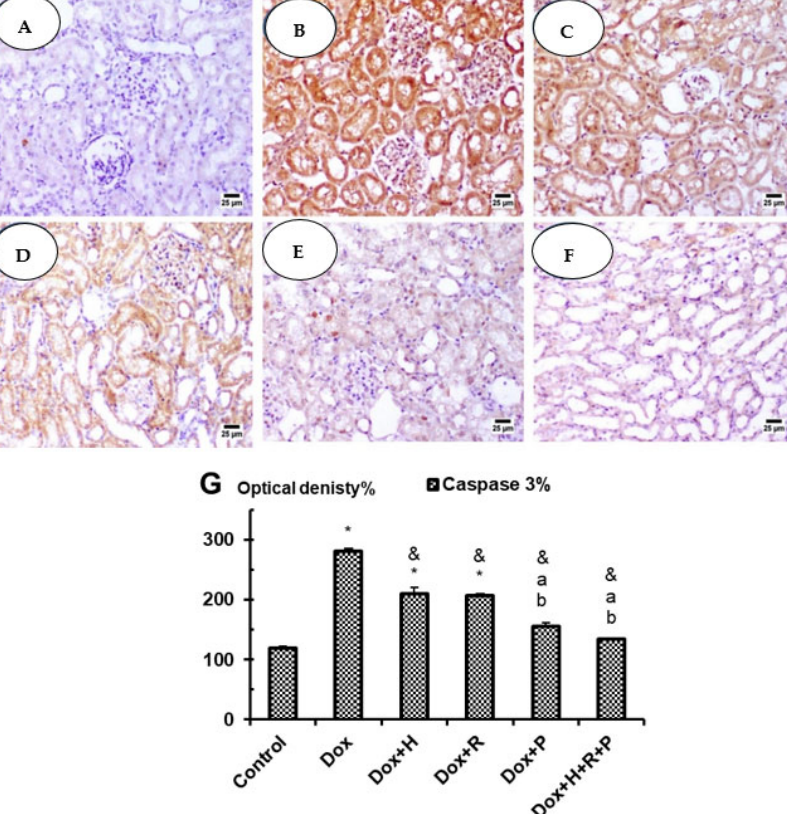
Figure 5. Control group ( A ) high power view showing negative expression of caspase 3 (immunostaining); Dox group ( B ) showing higher expression of caspase 3 (immunostaining); Dox + H group ( C ) and Dox + R group ( D ) showing moderate expression of caspase 3 (immunostaining); Dox + P group ( E ) and Dox + H + R + P group ( F ) show weak expression of caspase 3 (immunostaining). ( G ) Optical density% for Caspase 3 in experimental groups. Results are expressed as mean ± S.E.M. and analyzed using one ‐ way ANOVA followed by Bonferroni’s test for multiple comparisons. * p ≤ 0.05 versus control group. & p ≤ 0.05 versus Dox group. a p ≤ 0.05 versus Dox + H group. b p ≤ 0.05 versus Dox + R group. n = 5.